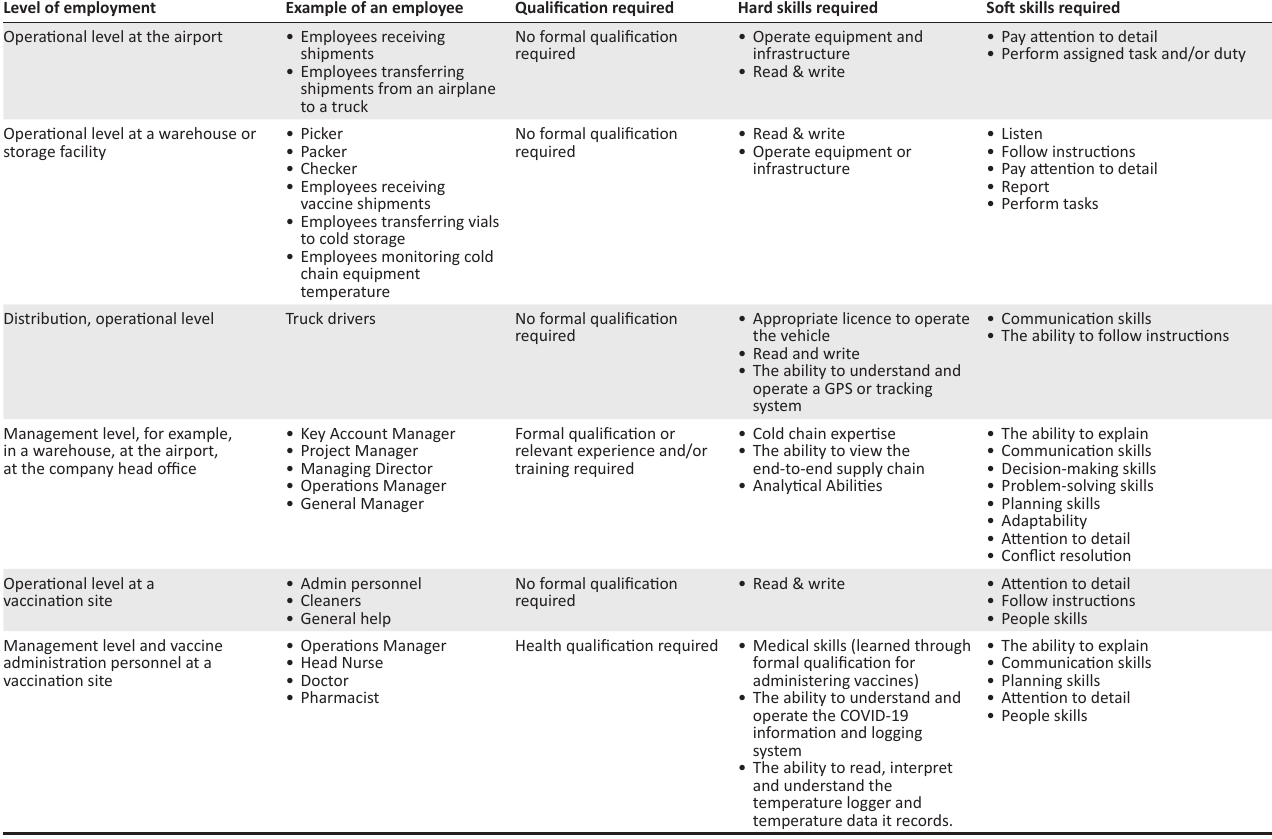
TABLE 3: Skills requirements (Toolkit element